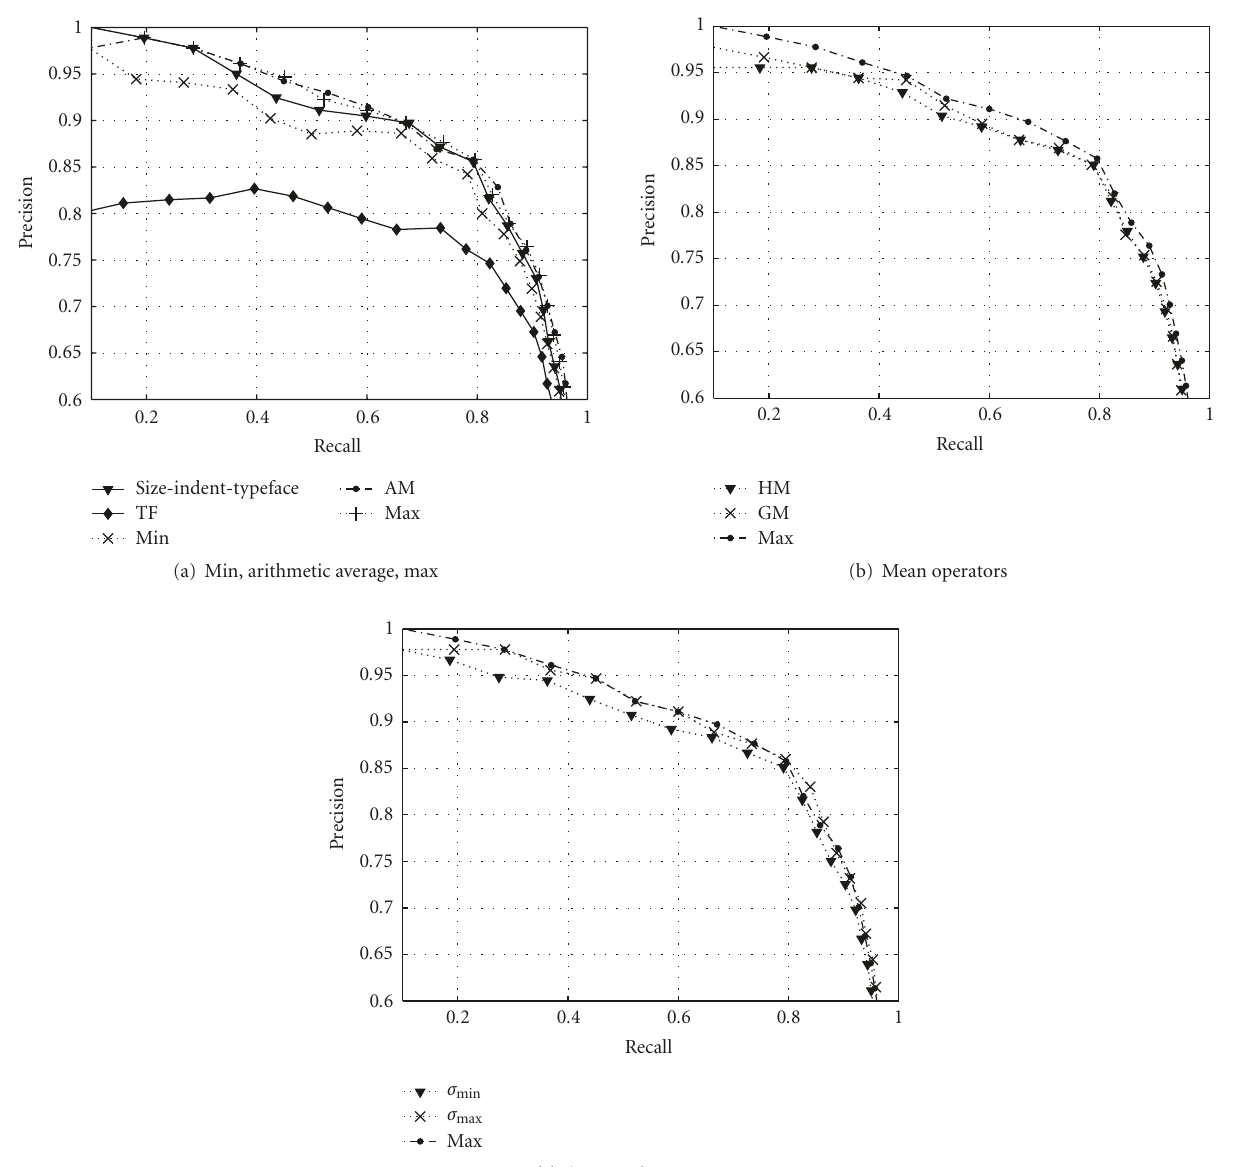
Figure 14: Precision-recall curves for aggregation of size, indent, attribute, and term frequency features using various aggregation